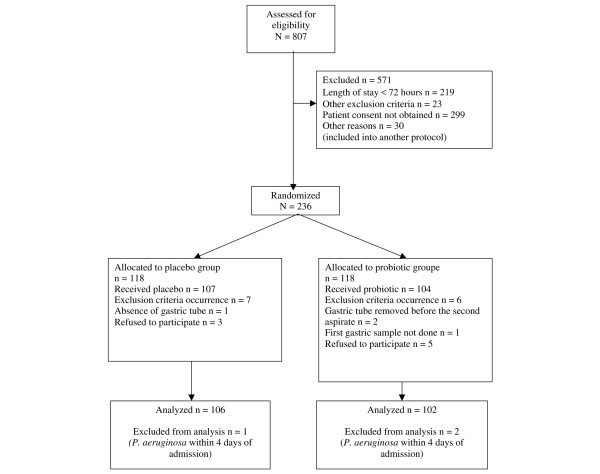
Patient flowchart.